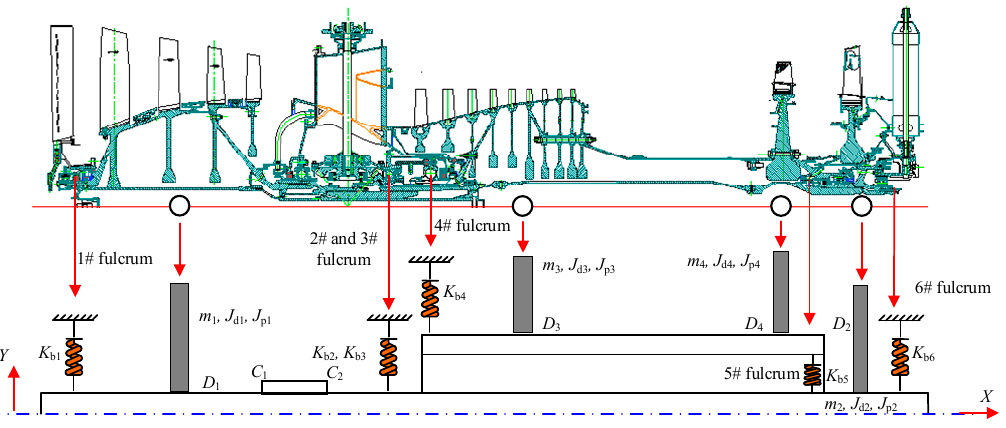
Figure 2. The diagram of the simplified dual-rotor model with four disks and five fulcrums.